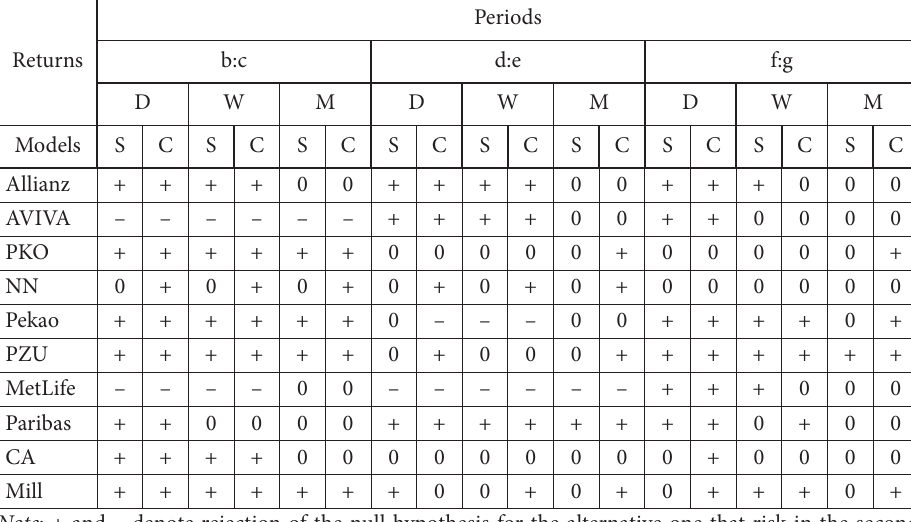
Table 10. Decision based on statistics (5) for equality of betas from single index (S) and capital assets pricing (C) models estimated for mutual funds in the considered periods (source: own calculations) Periods Returns b:c d:e